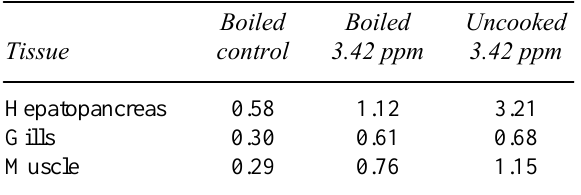
Table 6: Total arsenic content in boiled crawfish (in ppm) Tissue